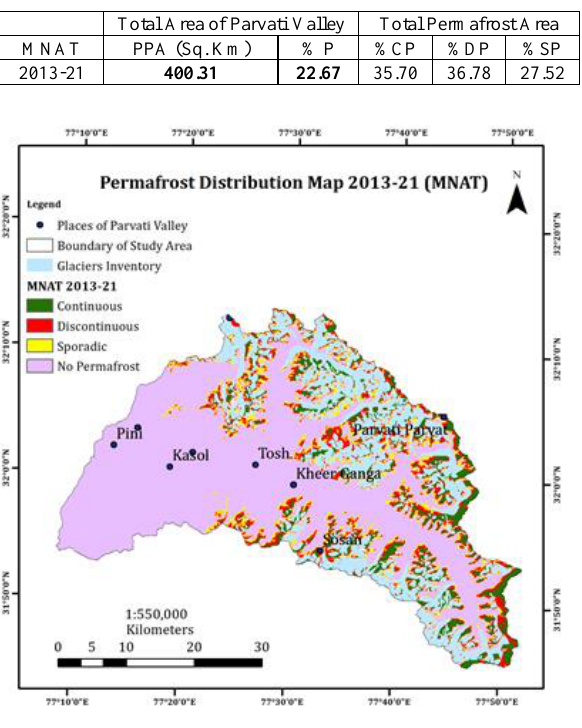
Figure 6: Google Earth Pro image showing the rock glaciers in the Parvati valley indicating the presence of